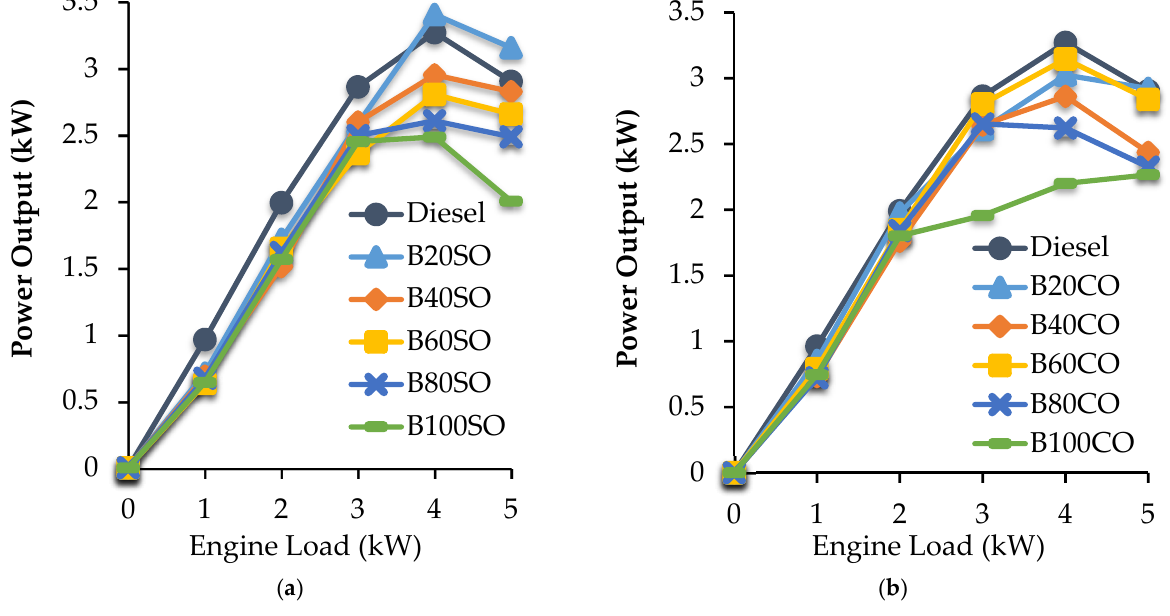
Figure 3. Power generated by the engine at different engine loads using the triple blends: diesel/ABE/sunflower oil ( a ) and diesel/ABE/castor oil ( b ).